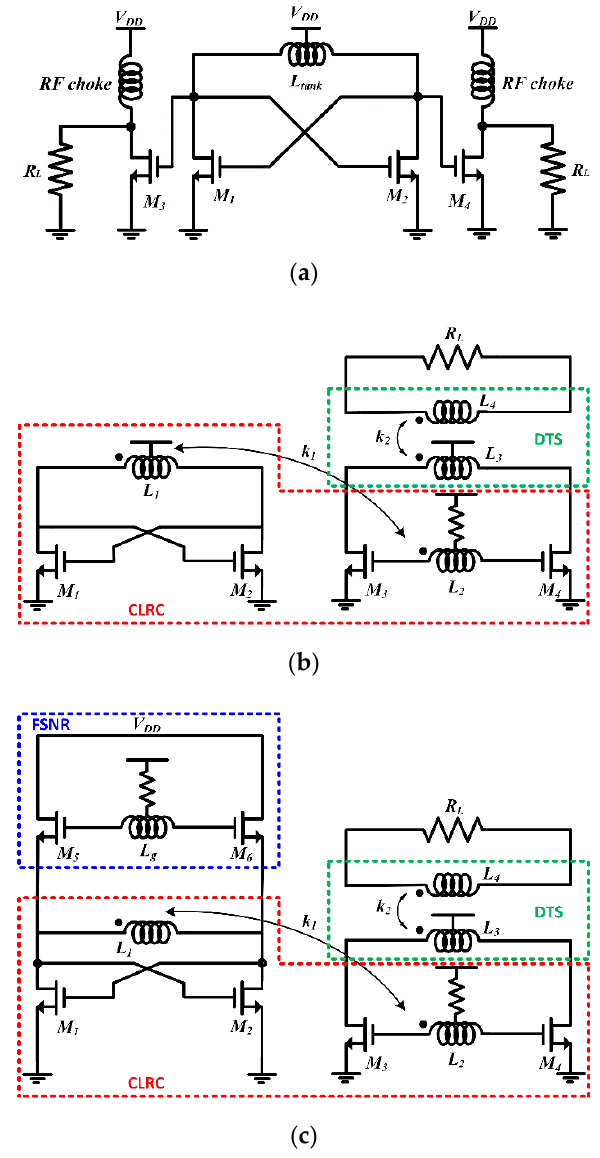
Figure 1. Schematics of ( a ) the conventional XCO; ( b ) the XCO with CLRC; ( c ) the proposed oscillator.